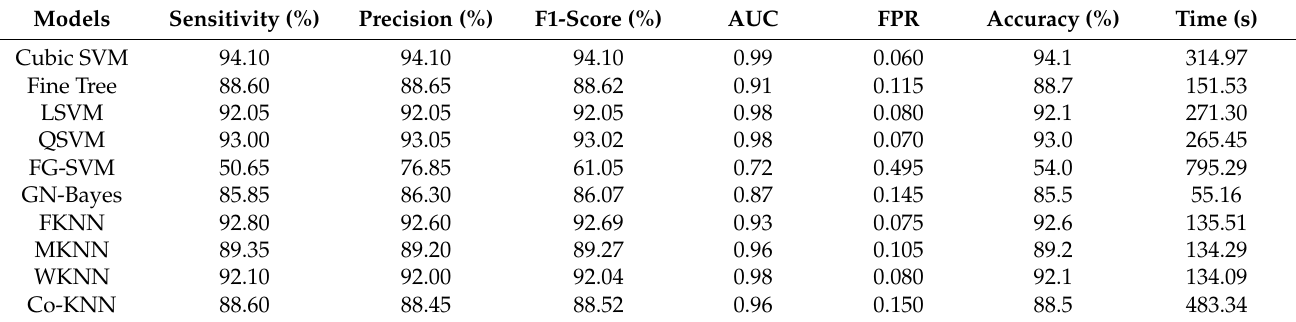
Table 6. Classification results using Fusion on MobilenetV2 and Nasnet deep features for CBIS-DDSM.